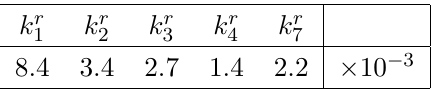
at the scale (cid:22) (cid:22) = 770 MeV extracted using i